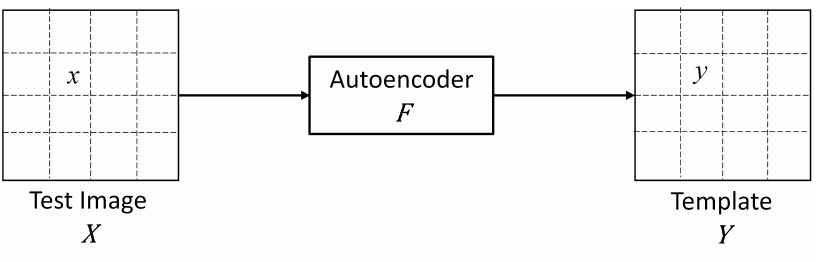
Figure 3. An example showing the relationship between a block x ∈ X and its counterpart y ∈ Y . In the example, the input test image is separated into 16 non-overlapping blocks with equal size. Each block x ∈ X and its counterpart y ∈ Y have the same size. The location of x in X is also the same as that of y in Y